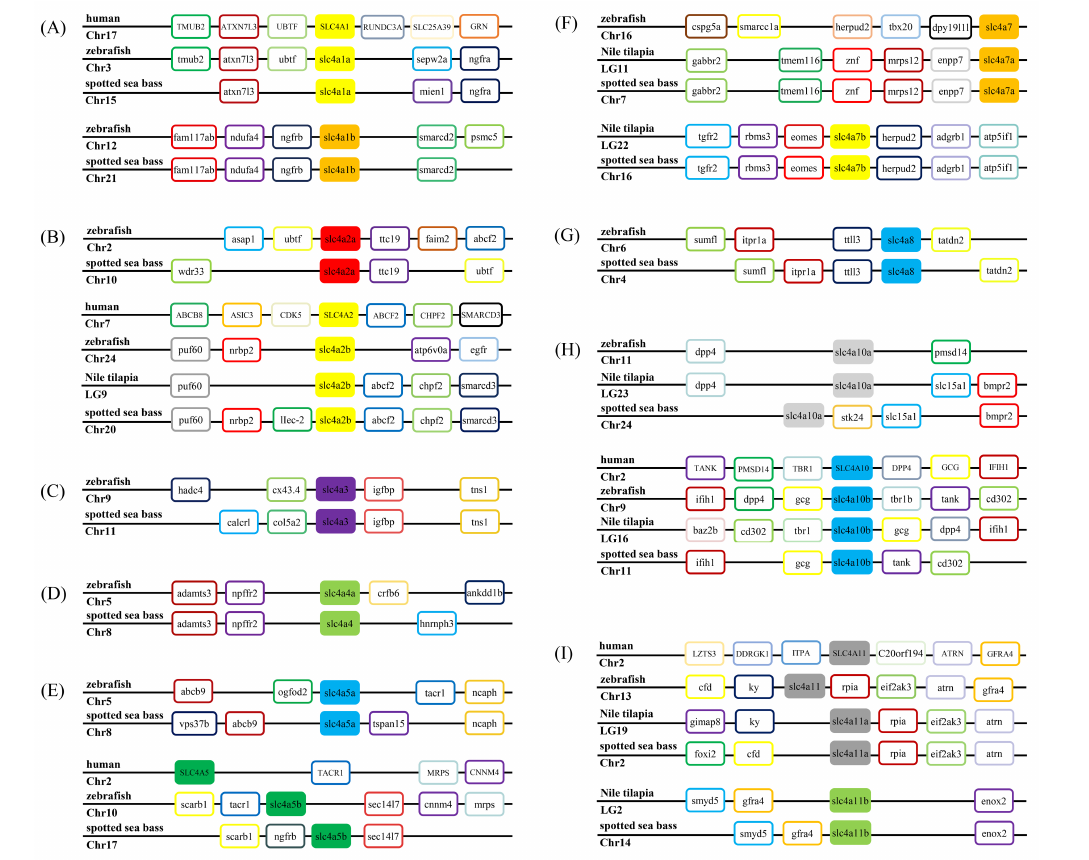
Figure 2. Syntenic analysis of slc4 genes in zebrafish, Nile tilapia, and spotted sea bass. ( A – I ): slc4a1 – slc4a11 . Full gene names are provided in Table